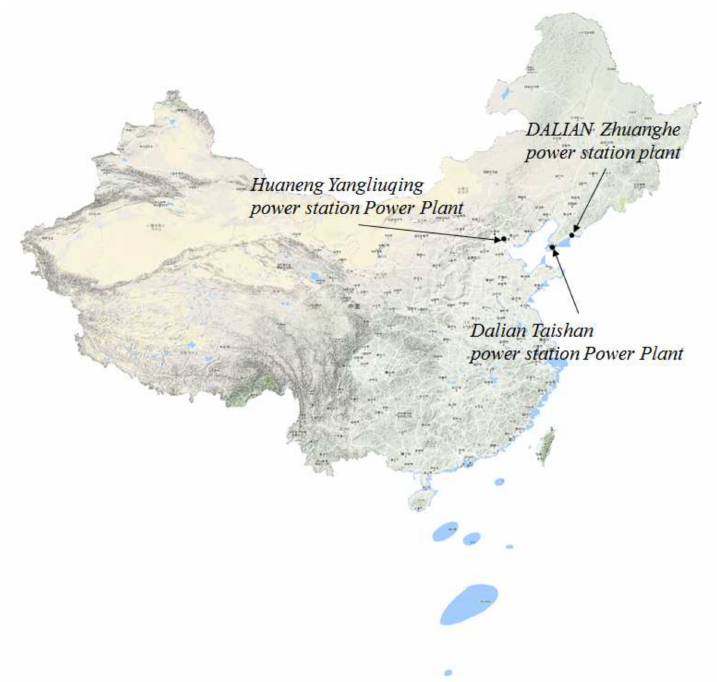
Figure A6. A map of three plants in China.